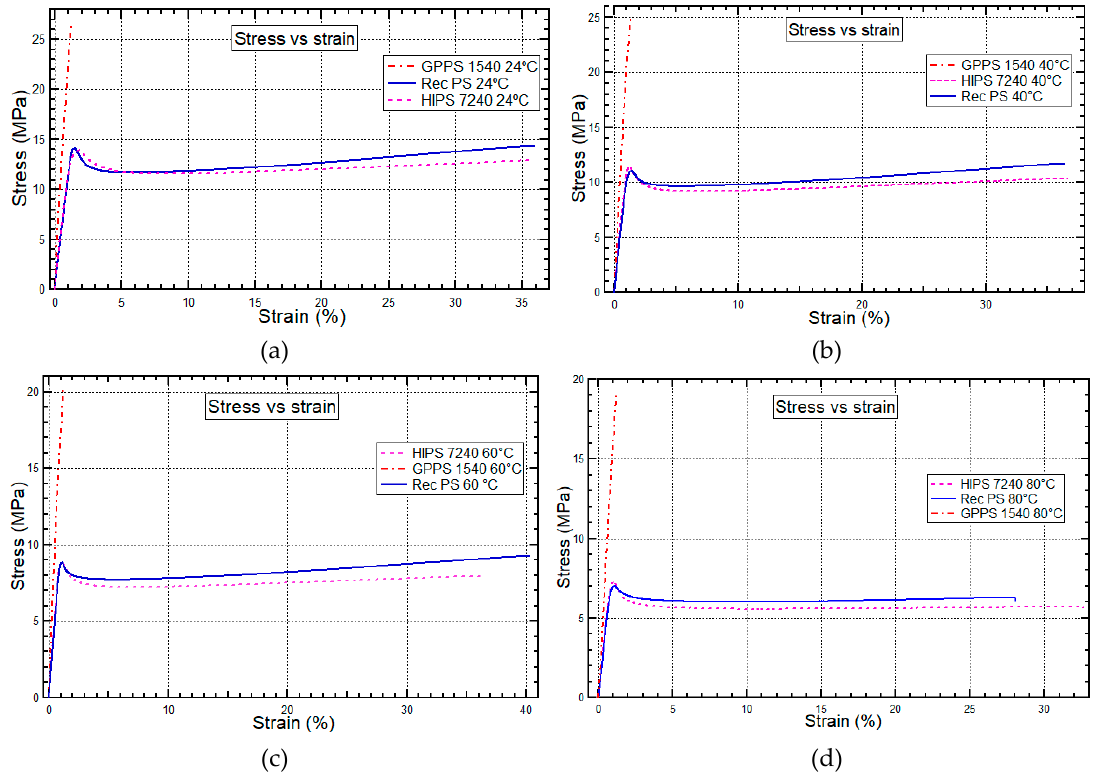
Figure 4. Stress vs. strain behavior for HIPS 7240, GPPS 1540, and recycled PS at 24 °C, 40 °C, 60 °C, and 80 °C.